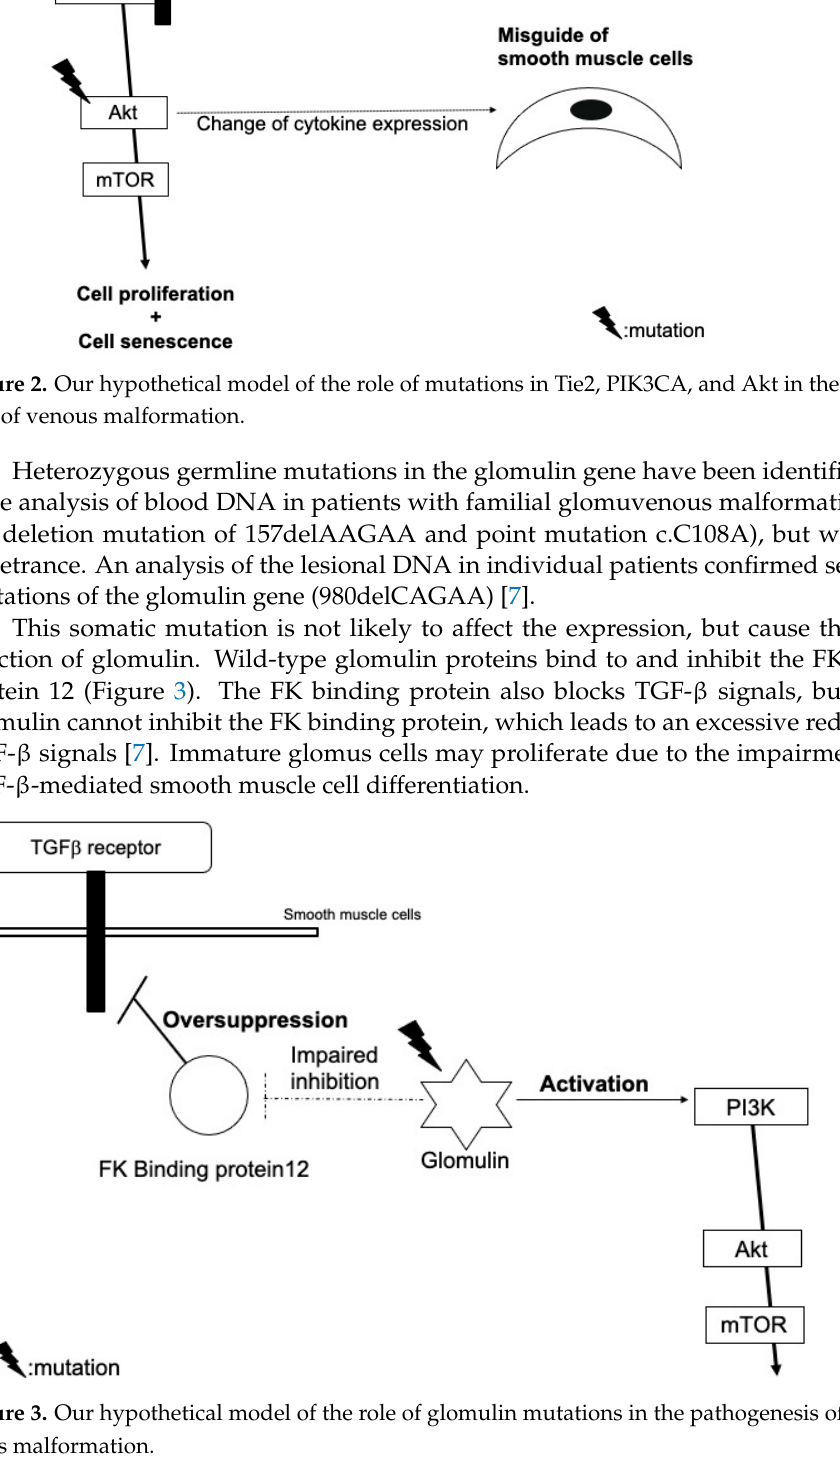
Figure 3. Our hypothetical model of the role of glomulin mutations in the pathogenesis of glomu- venous malformation.